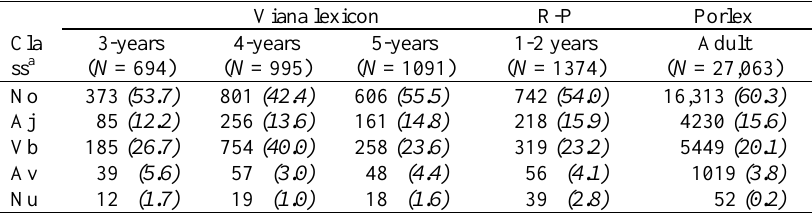
Table 2. Number (and %) of entries per grammatical class in the Viana, Ramos-Pereira (R-P) and Porlex lexicons/databases. Viana lexicon R-P